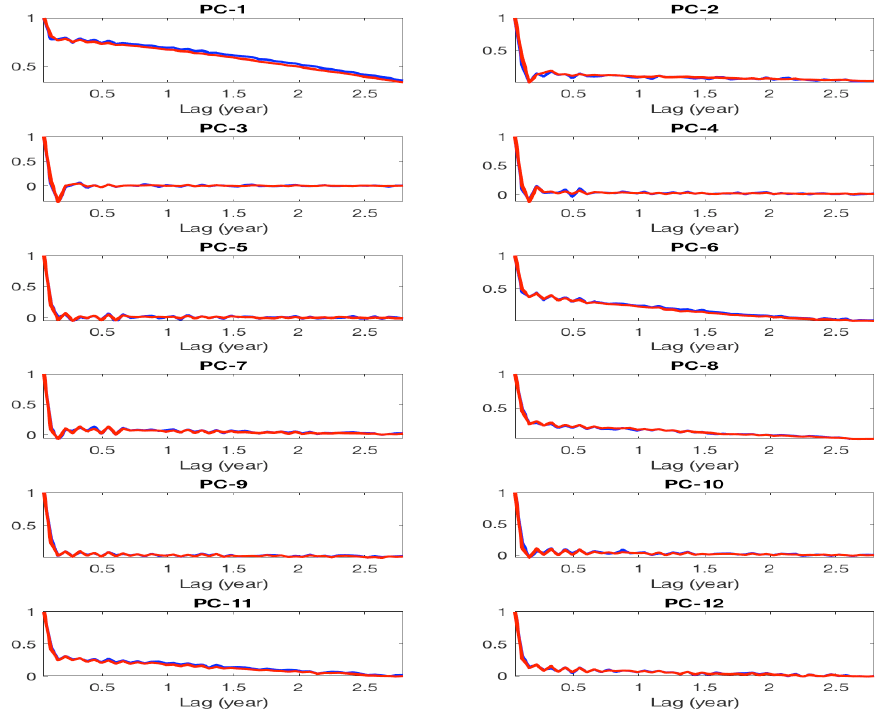
Figure A6. Same format as in Figure A8, but the comparison of harmonic reconstruction (red) and DAH-MSLM stochastic simulation (blue) in a full frequency band f < 9.1 y − 1